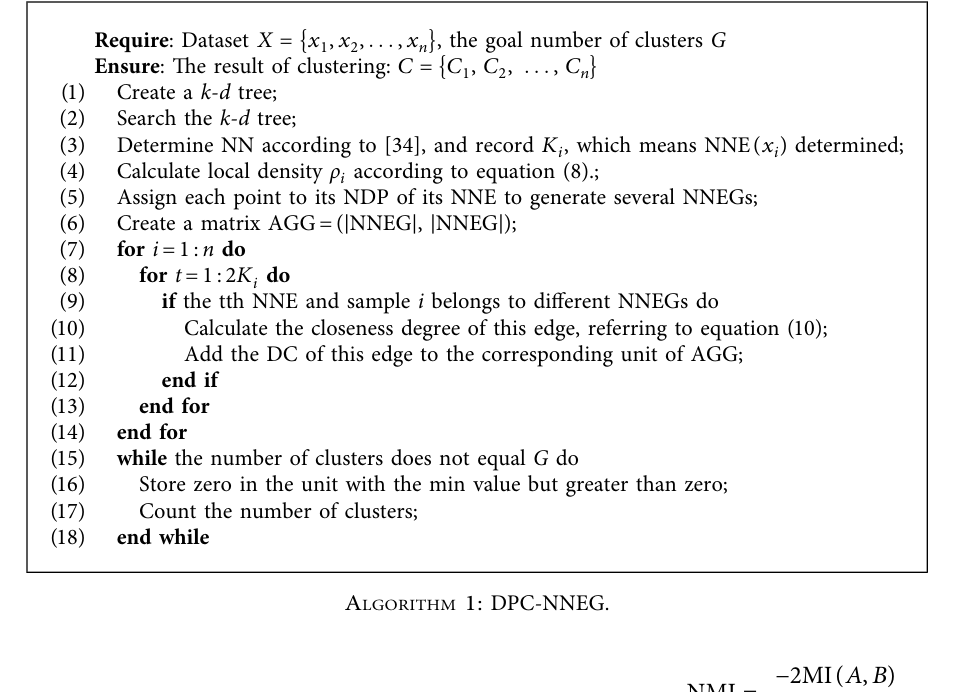
Table 2: Detailed information on tested datasets.